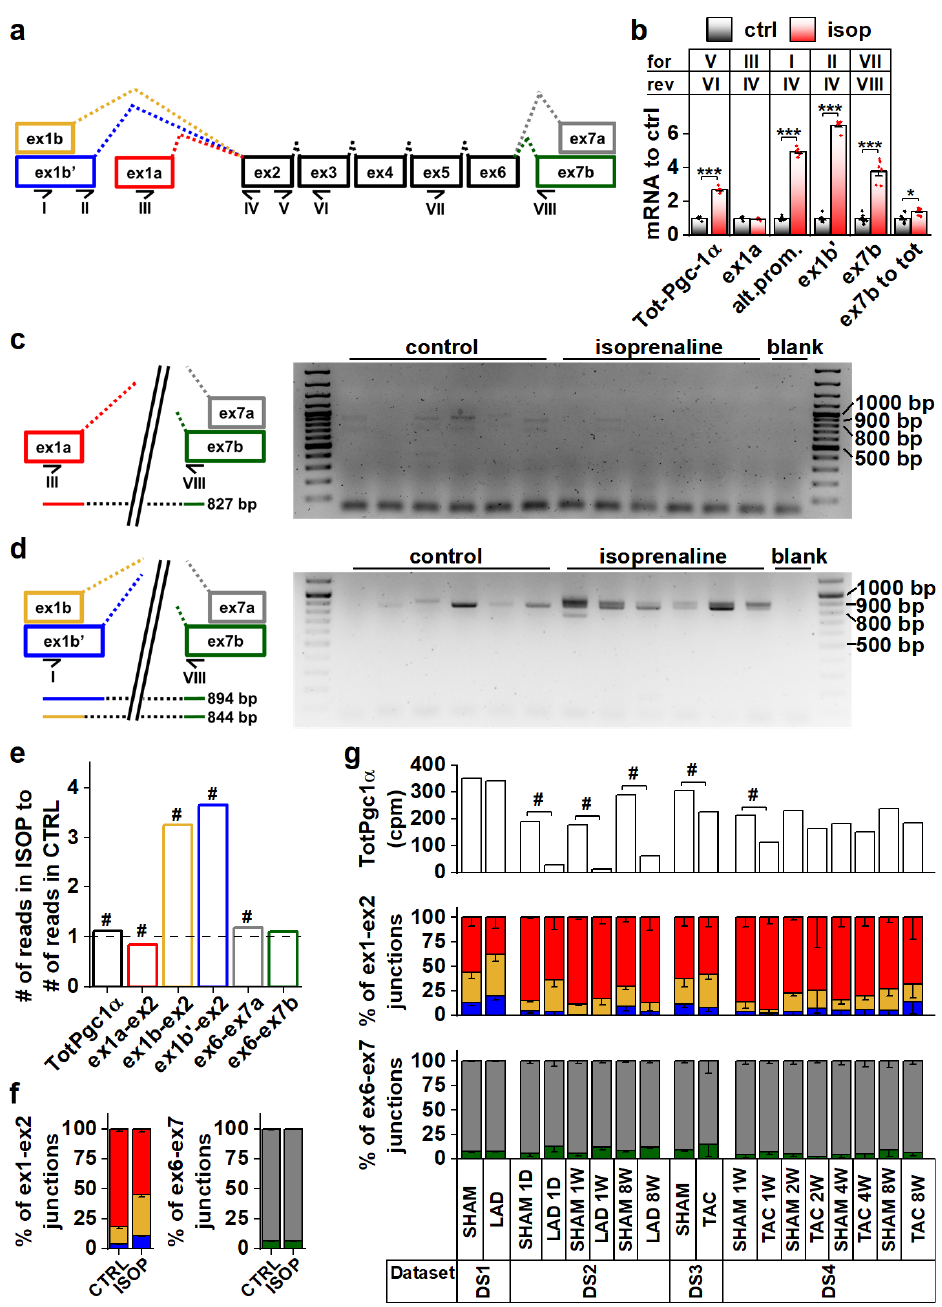
Figure 1. Pgc-1 α isoforms arising from differential promoter usage and mRNA splicing are expressed in cardiac tissue. ( a ) Schematics showing the different Pgc-1 α exons and splicing events present in the mouse heart. Primers detecting expression of specific exons are identified by Roman numerals. Colour coding of exon-exon junctions is used in subsequent panels presenting RNA sequencing data. ( b ) RT-qPCR analysis of total and exon expression of Pgc-1 α in adult cardiomyocytes exposed to 100 nM isoprenaline for four hours ( n = 6). Names of the primers (for/rev) used in each assay refer to panel a. ( c ) Gel electrophoresis from PCR reaction detecting expression of N-terminal Pgc-1 α from the proximal promoter ( NT-Pgc-1 α -a ) from isoprenaline-exposed adult mouse cardiomyocyte cDNA. Schematic on left shows how the PCR product is produced from the transcript. ( d ) Gel electrophoresis from PCR reaction detecting expression of N-terminal Pgc-1 α from the alterna- tive promoter ( Pgc-1 α 4 and NT-Pgc-1 α -c ) from isoprenaline-exposed adult mouse cardiomyocyte cDNA. Schematic on left shows how PCR products are produced from the transcripts. ( e ) Ratio of total Pgc-1 α expression and individual exon-exon junctions in hearts of adult mice treated with iso- prenaline compared to vehicle control ( n = 56). Bar colours of exon-exon junction ratios refer to col- ours in panel a. ( f ) Ratios of RNA sequencing reads aligning to different exon 1-exon 2 (left) and